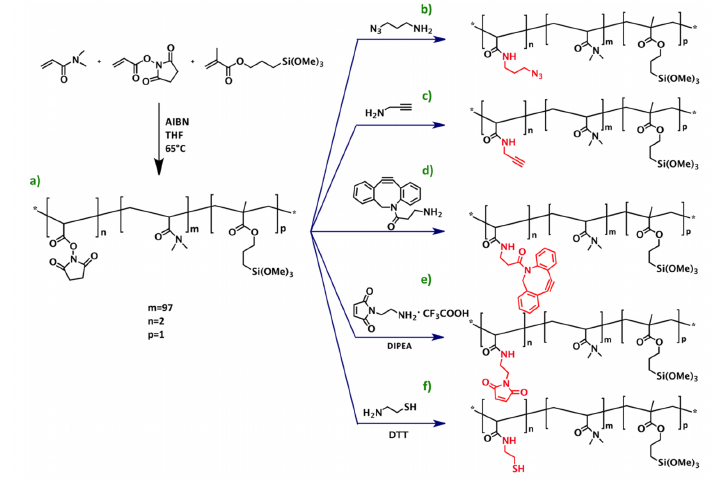
Figure 2. Scheme of the synthesis of copoly(DMA-NAS-MAPS) ( a ) and its derivatives obtained through post-polymerization modification (PPM), copoly azide ( b ), copoly alkyne ( c ), copoly DBCO ( d ), copoly maleimide ( e ), and copoly thiol ( f ). Here AIBN is a short for Azobisisobutyronitrile, THF for Tetrahydrofuran, DIPEA for N,N-Diisopropylethylamine, and DTT for Dithiothreitol. The asterisk in inset ( a ) indicates where the functional groups are being linked. Reprinted with permission from [69], copyright (2016) American Chemical Society.